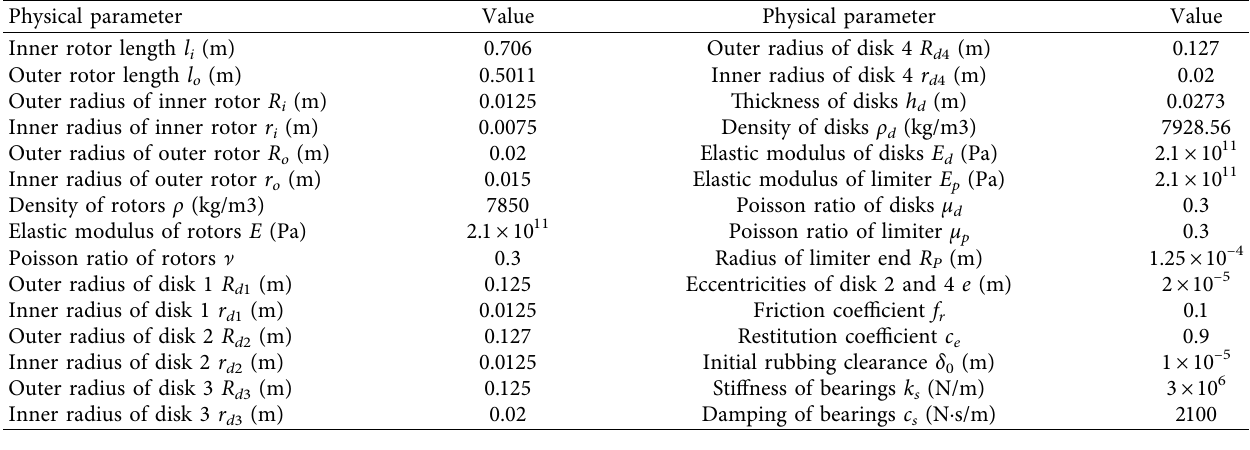
Figure 7: Finite element model of the dual-rotor system [15]. Table 1: The main parameters of the dual-rotor system [15].